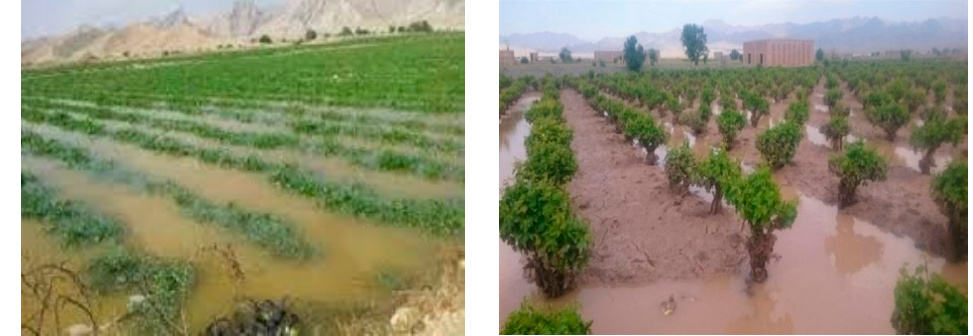
Figure 3. The water retention in the southern parts of the studied region with agricultural use due to 3 ‐ day rainfall in rainy seasons in 2021.